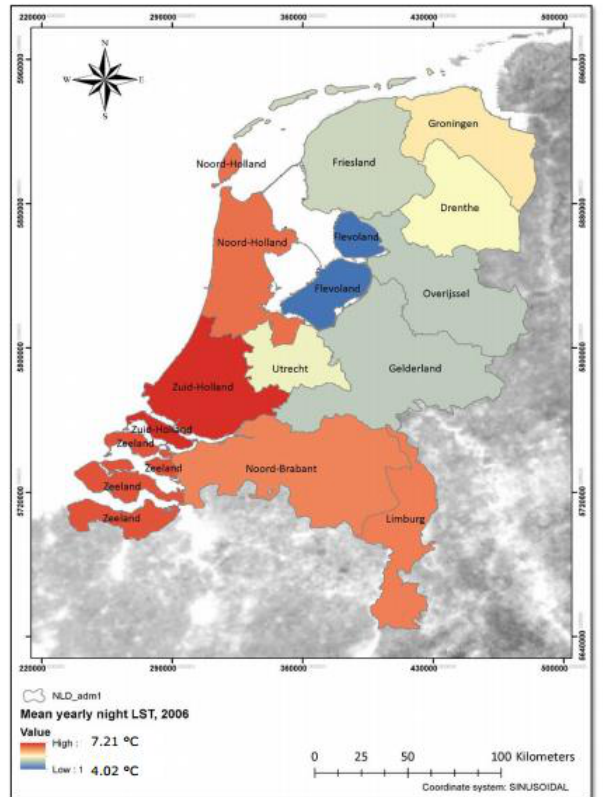
Figure 1. The up-scaled mean yearly night LST mean to the Dutch provinces scale in 2006